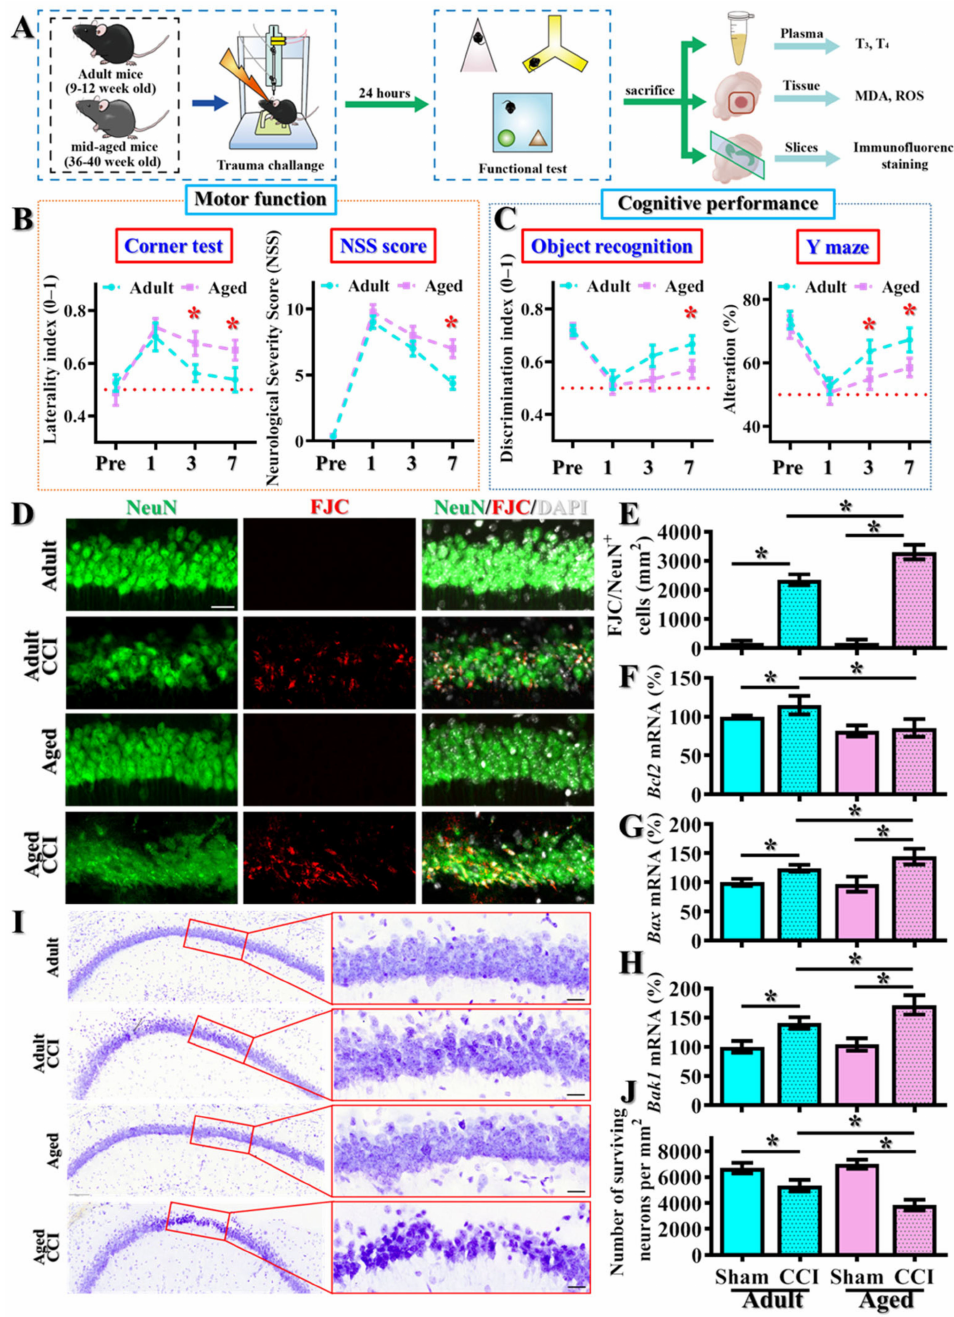
Figure 1. Increase in TBI-susceptible phenotypes in the middle-aged animals. ( A ) Schematic illustra- tion of experimental designs; ( B ) Behavioral performance of motor function, including corner test and neurological severity scores at different time points after CCI challenge; ( C ) Behavioral performance of cognitive function in an object location recognition task and spontaneous alternation Y maze. Data are presented as mean ± SEM. n = 8 to 10 mice; ( D , E ) Quantification and representative images of FJC-positive degenerating neurons. n = 15 images from 5 mice; ( F – H ) Quantification of the relative expression levels of Bcl2 , Bax and Bak1 mRNAs from different experimental groups. n = 5 mice; ( I , J ) Quantification and representative images of Nissl stains showing the surviving neurons. n = 15 images from 5 mice. Data are presented as mean ± SEM in ( E – J ) and analyzed by a one-way ANOVA with Bonferroni’s post hoc analysis. * p < 0.05. Scale = 25 µ